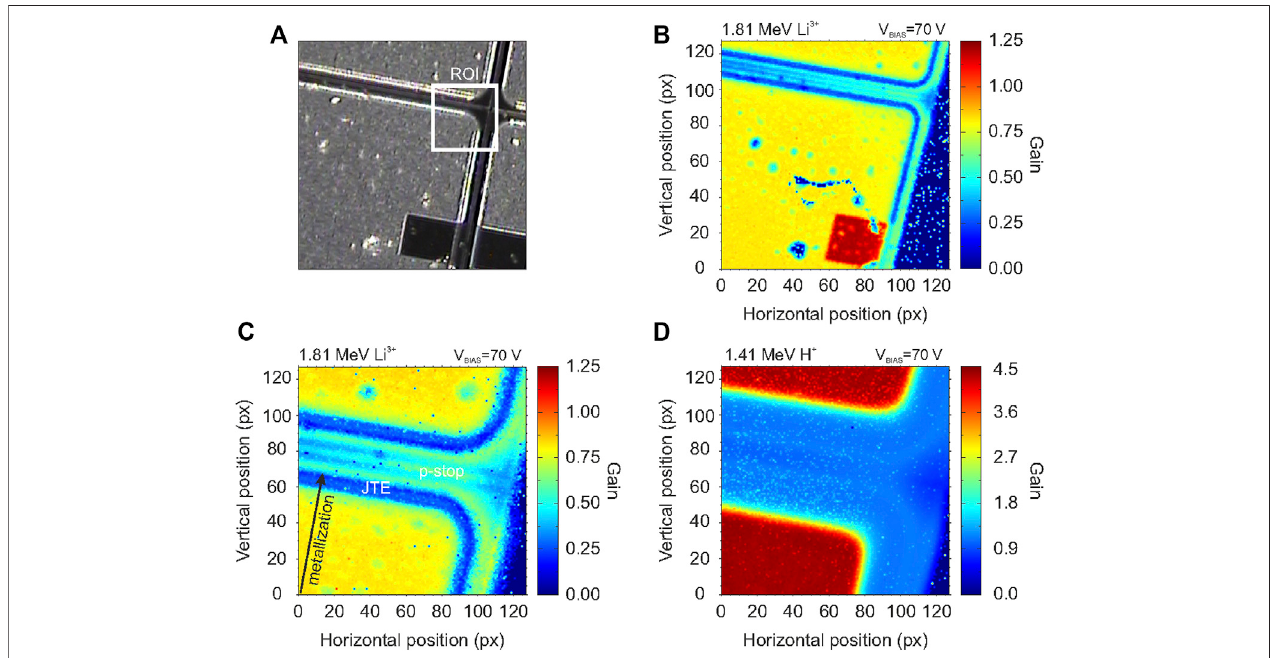
FIGURE3|(A) OpticalimageoftheintergapregionofsampleAwithopeninginmetallizationforlaserlighttests(atbottomright); (B) 1.81 MeV 7 LiionIBICimageof 570 × 570 μ m 2 scan area; (C) 1.81 MeV 7 Li ion IBIC image of 190 × 190 μ m 2 scan area, arrow is indicating extension of the metallization contact for the lower pad; (D) 1.41 MeV proton beam IBIC of the same area as in (C) . Small patches of low ef fi ciency visible at (B,C) are due to the dust particles at detector surface.